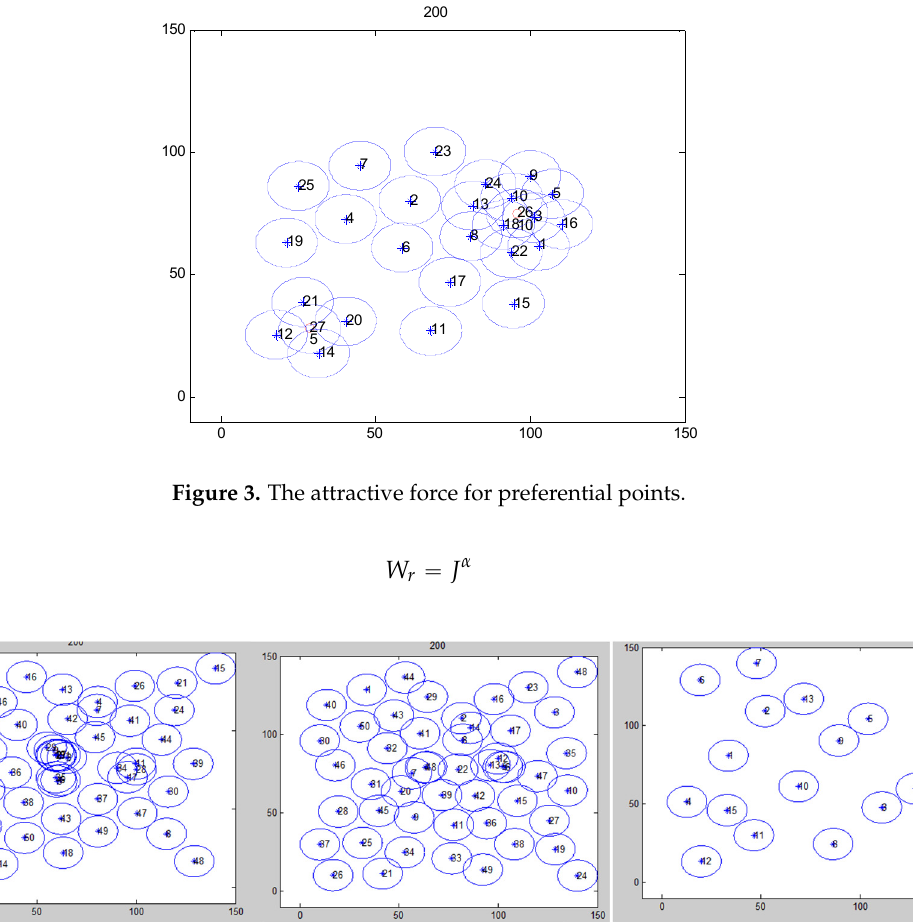
Figure 5. Limit step size, and N = 20.